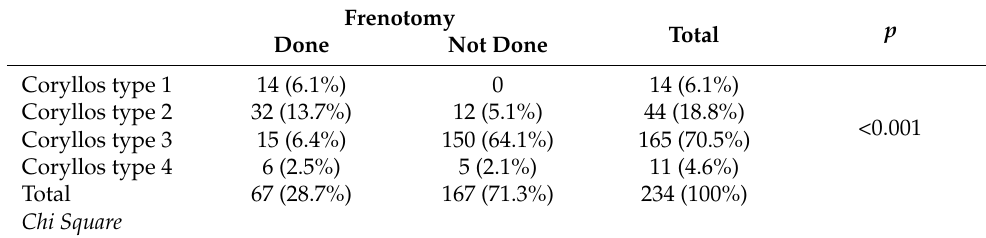
Table 2. Coryllos groups and frenotomy distribution.